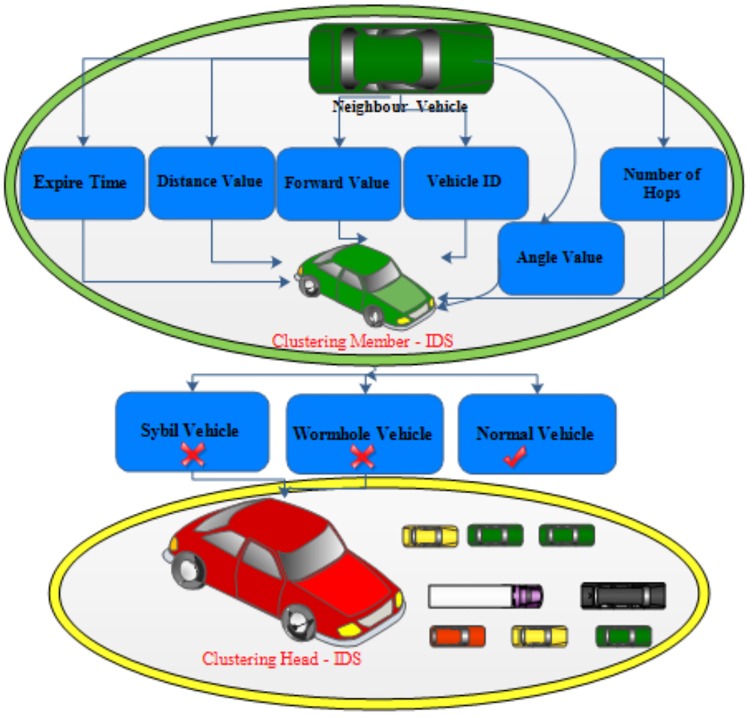
IDS architecture.